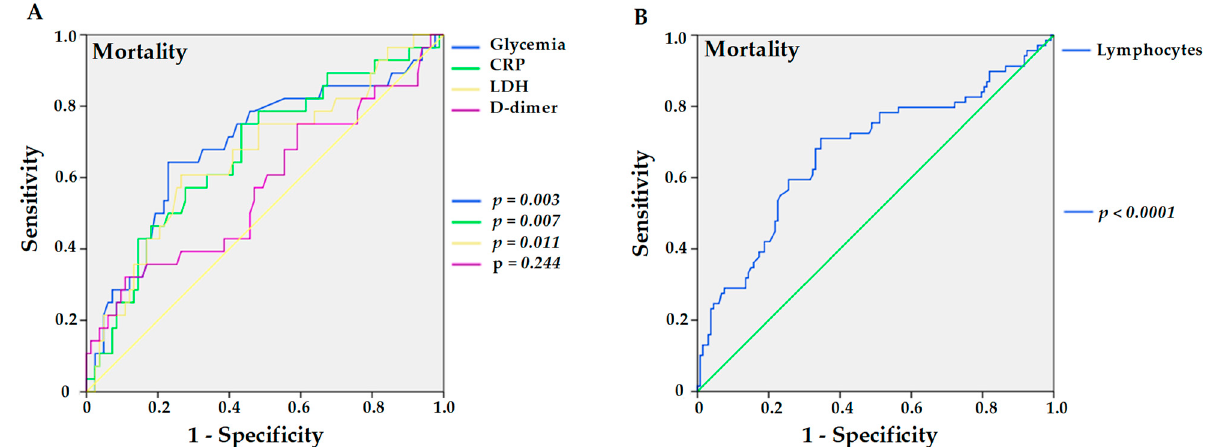
Figure 1. Sensitivities and specificities of higher levels of previous glycemia ( p = 0.003), C-reactive protein (CRP, p = 0.007), lactate dehydrogenase (LDH; p = 0.011), and D-dimer ( p = 0.244) ( A ), and lower levels of lymphocytes ( p < 0.0001) ( B ) in hypertensive kidney transplant recipients with COVID-19 for the outcome of mortality.